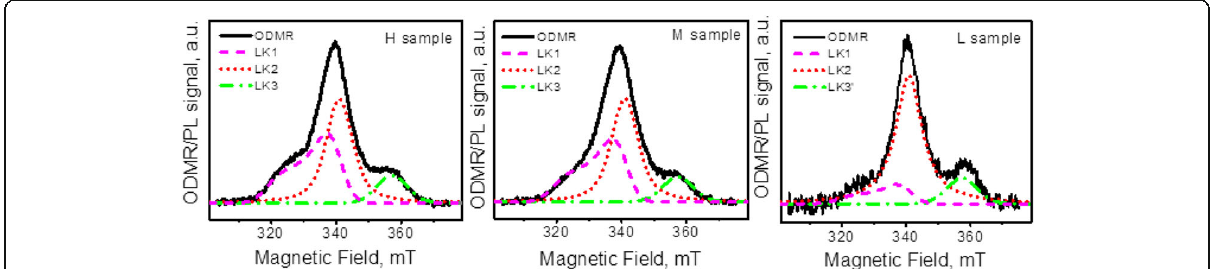
Fig. 4 Fitting of the ODMR spectra. Fitting of the ODMR spectra of the composites by changing only the relative intensities of three